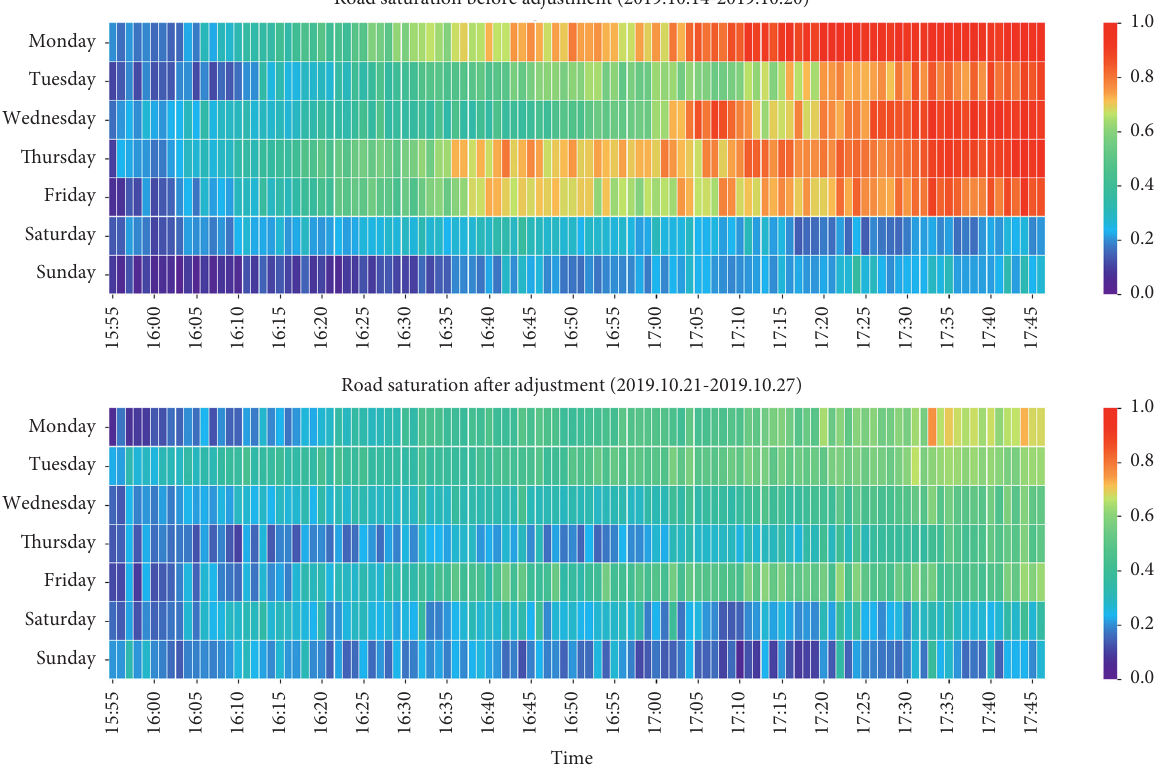
Figure 16: Road saturation before and after adjustment in link 1. Table 4: High-frequency vehicles’ compliance